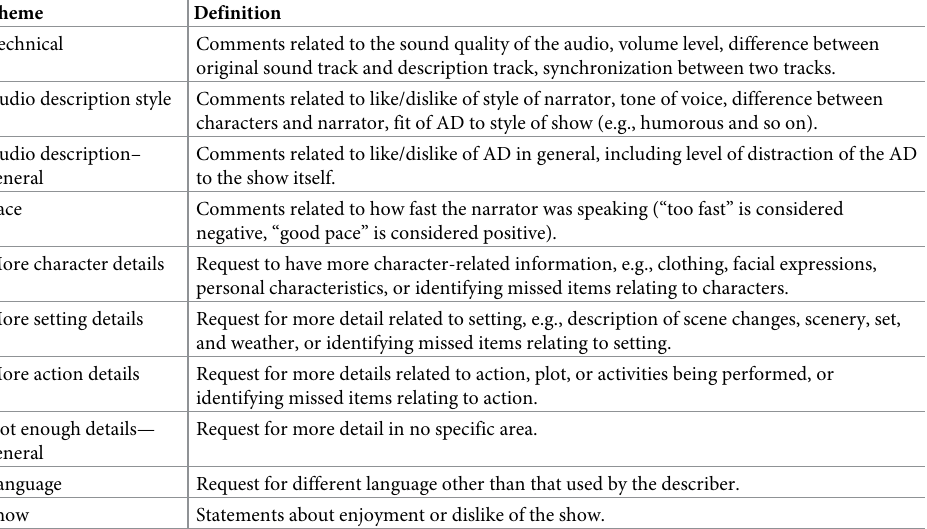
Table 1. Themes for the open-ended questions in the between-episode